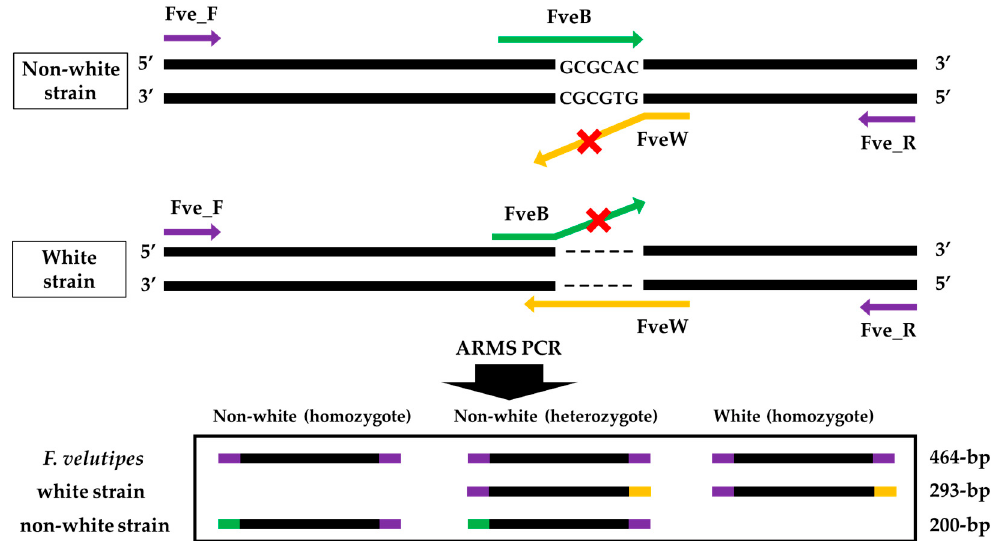
Figure 3. Primer design for non ‐ white or white Flammulina velutipes strain discrimination by amplification refractory mutation system (ARMS) PCR. Primers were designed to amplify the Fvpal1 gene with 464 bp and 200 bp, 464 bp and 293 bp from non ‐ white and white strain, respectively. A heterozygote of the Fvpal1 gene would be expected to show all three bands.